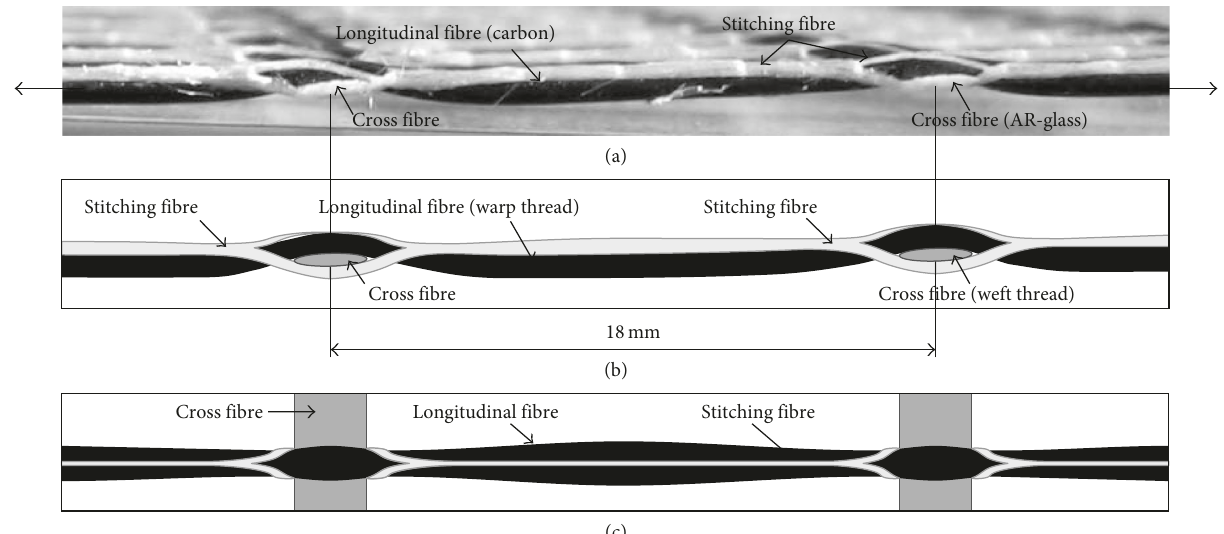
Figure 2: Undulation and variation of cross section of longitudinal fibres (warp threads) in a textile. (a) Photograph, (b) side view, and (c) top